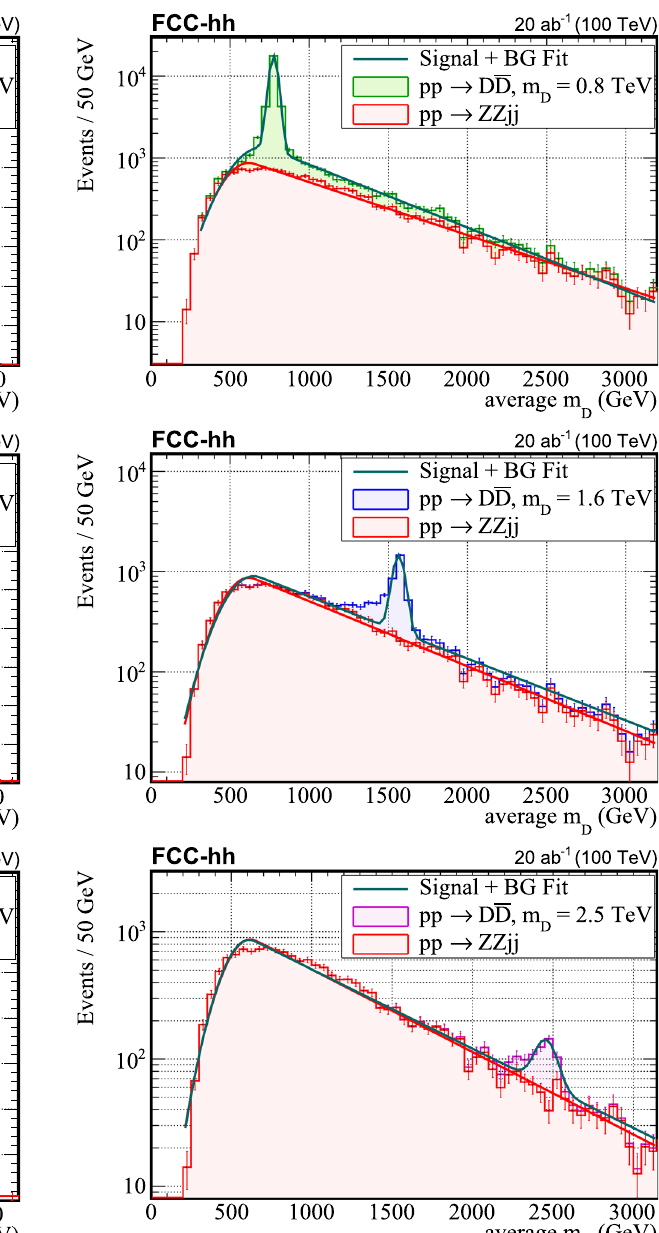
Fig. 7 Distribution of average reconstructed D quark invariant mass ( m + m )/ 2 for HL-LHC conditions for background and signals D 1 D 2 with m D = 600 GeV (top), 800 GeV (middle) and 1000 GeV (bottom). Results of the fit to the sum of a Gaussian and Crystal Ball functions are also shown